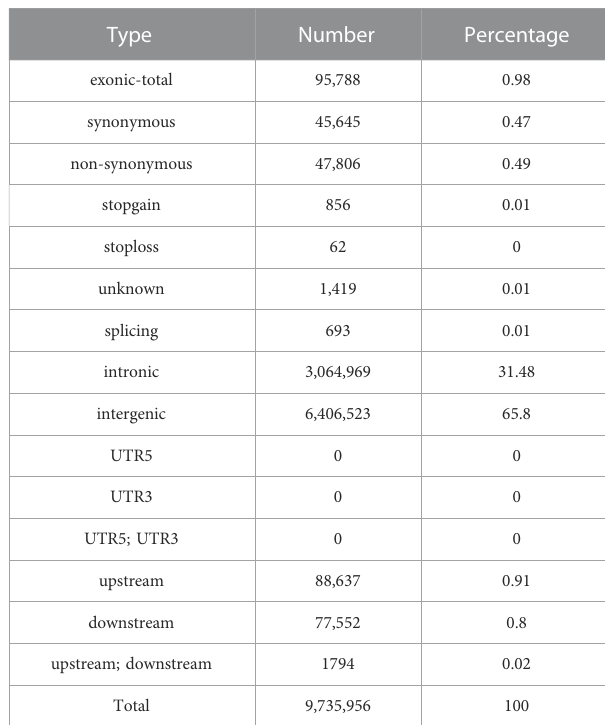
TABLE 1 Statistical description of phenotypic data. TABLE 2 SNP annotation